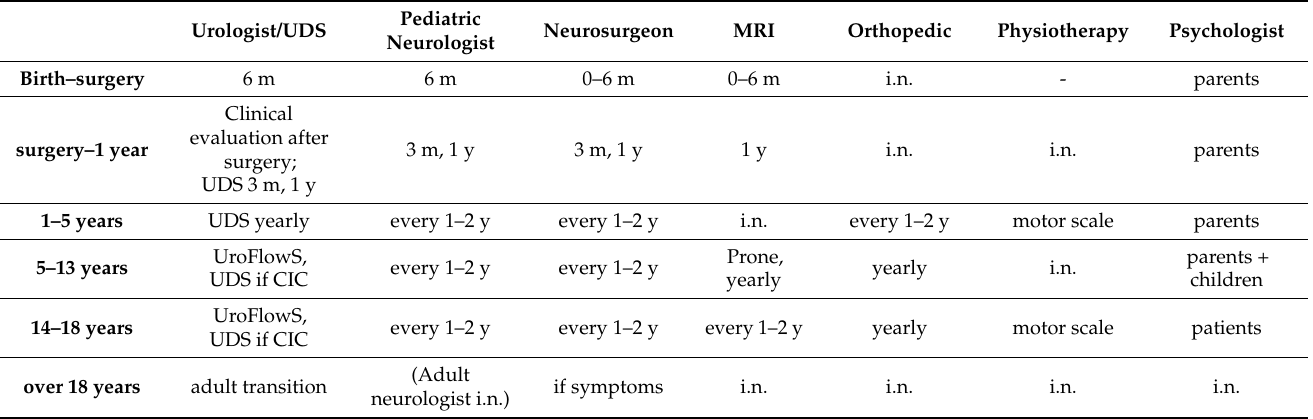
Table 1. Schematic management of children with occult spinal dysraphism according to the chil- dren’s